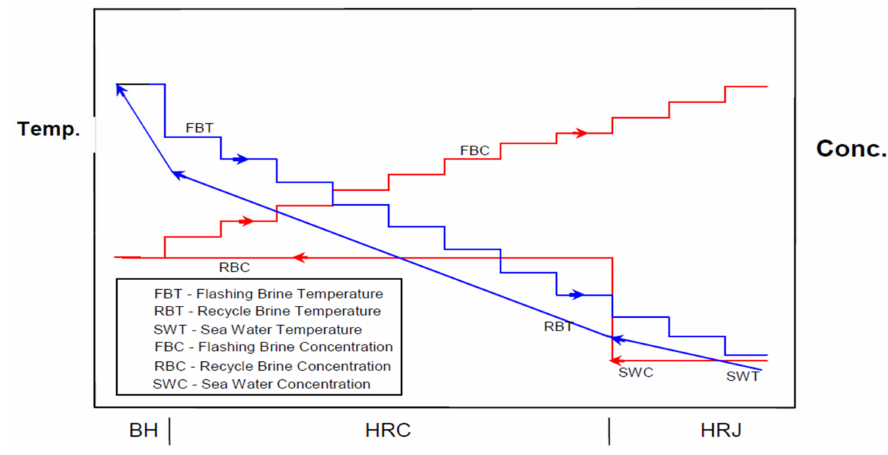
Figure 15. Temperature and concentration gradients in MSF distillers